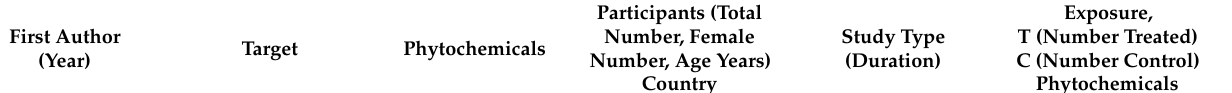
Table 4. Summary of selected studies regarding the therapeutic area of immunity and ENT